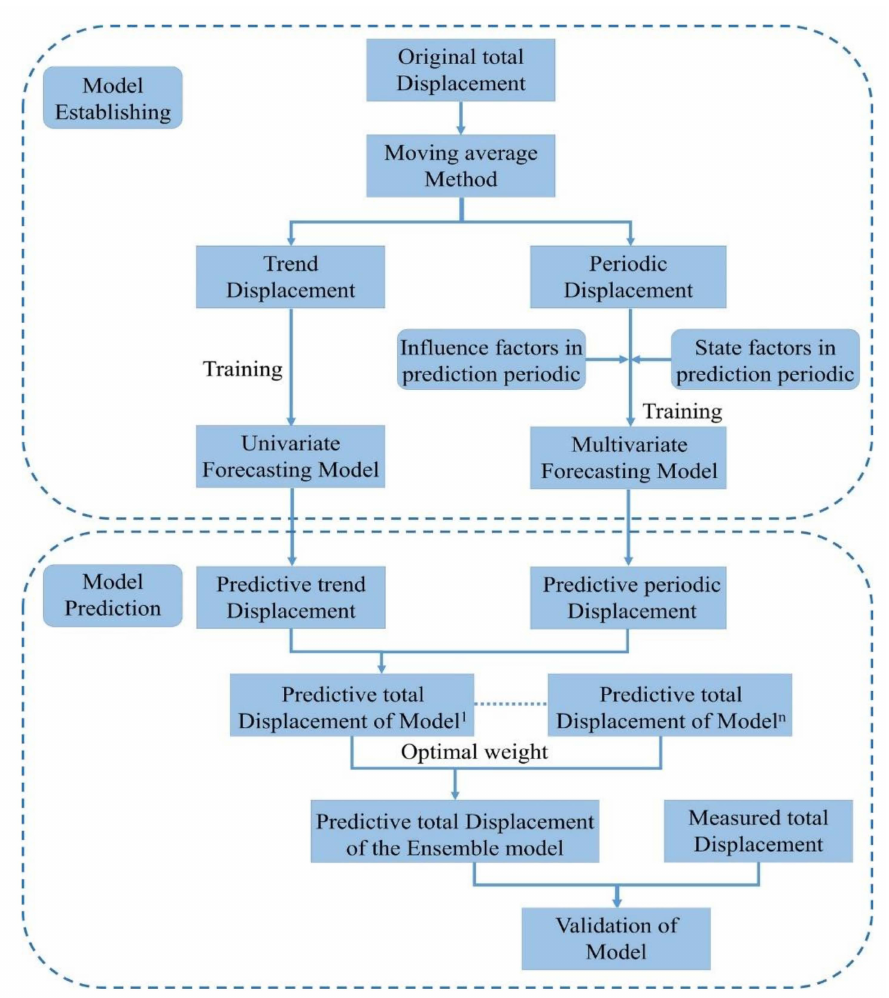
Figure 3. Flowchart of the proposed predictive